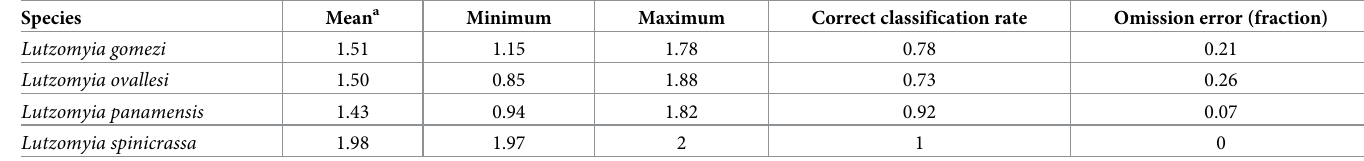
Table 1. Results of partial ROC analysis to test the statistical significance of ecological niche model predictions for the Neutral 2012–2015 episode. Species